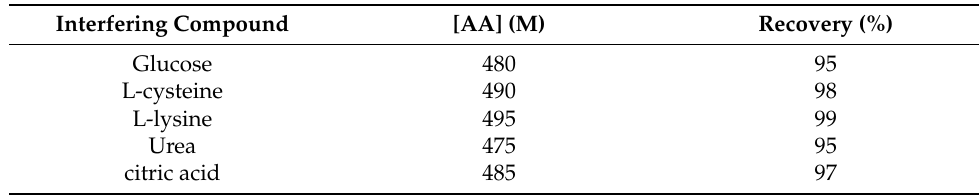
Table 4. Influence of interfering compounds on AA response of the h-nPG sensor. Interference amount added = 500 M.